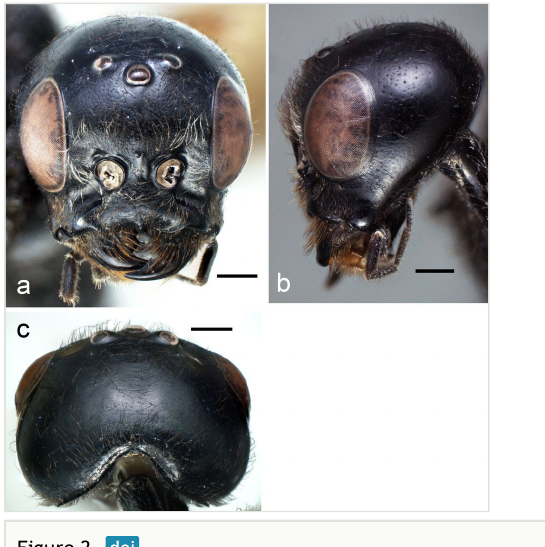
Figure 2. Pristaulacus emarginaticeps male. Scale bars 0.5 mm. a : head, frontal view; b : head, lateral view; c : head, dorsal view.